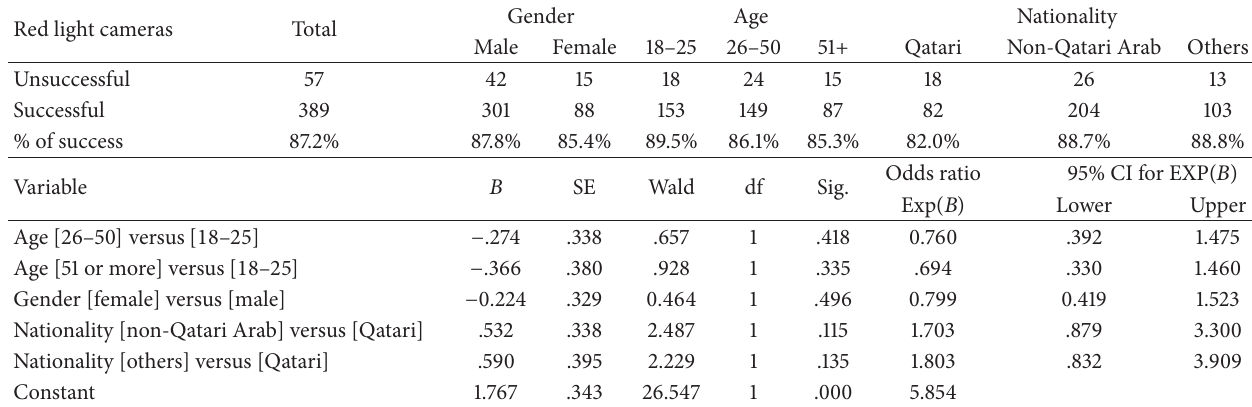
Table 3: Reported success and logistic model results for the red-light cameras